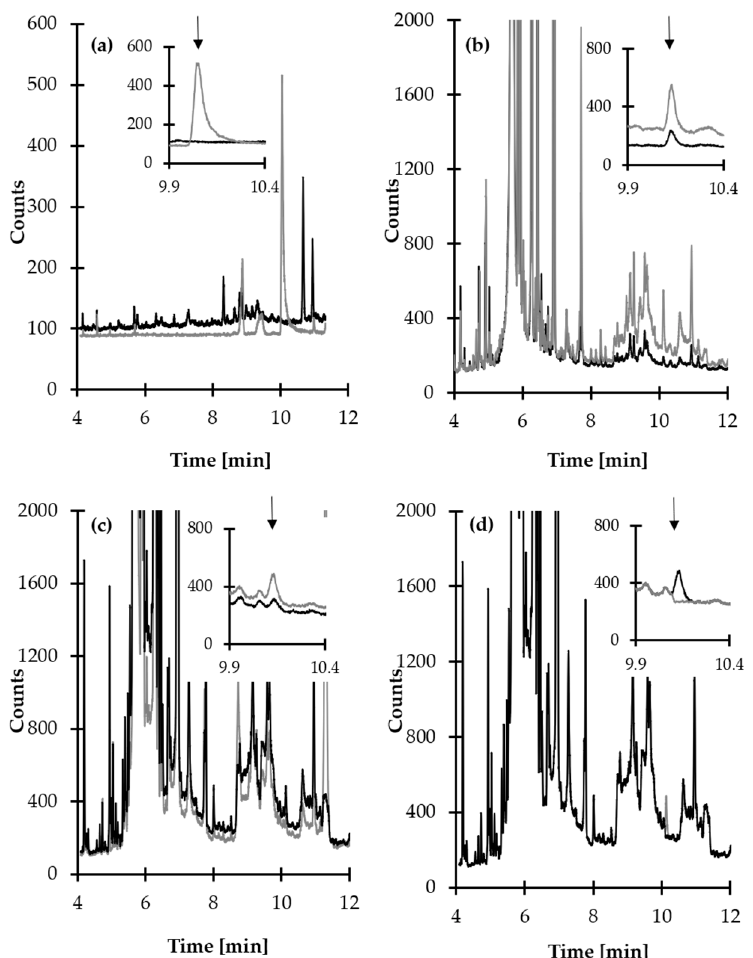
Figure 7. Representative chromatograms of standard solutions and human plasma prepared according to the procedure described in Section 3.6. Chromatographic conditions were as described in Section 3.7. ( a ) Blank standard solution (black line) and standard solution of HPPTCA (10 µmol L − 1 ) (grey line); ( b ) normal human plasma sample (black line) and the same sample spiked with HPPTCA (10 µmol L − 1 ) (grey line); ( c ) human plasma collected before (black line) and after 12 h intake of vitamin B6 (grey line); ( d ) normal human plasma sample (black line) and the same sample after alkalization (grey line).